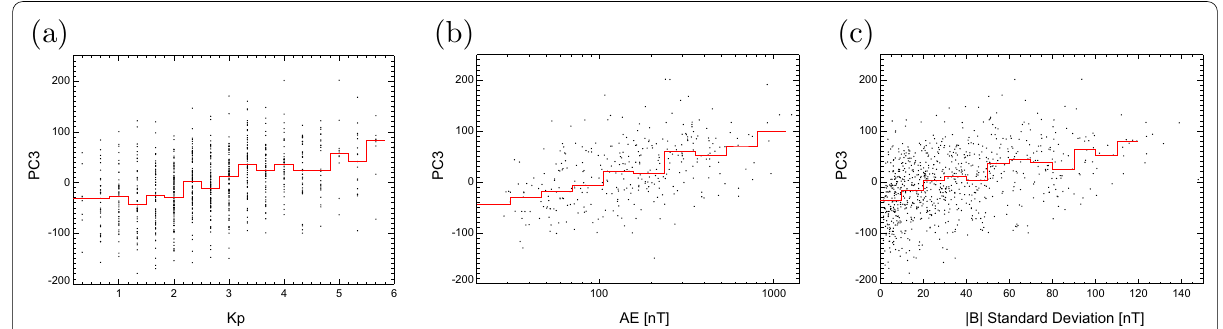
Fig. 5 Dependence of the PC3 coefficients on ( a ) Kp index, ( b ) AE index, and ( c ) standard deviation of the magnetic field magnitude measured by the Sodankylä magnetometer. Black points correspond to the values obtained for individual frequency–time spectrograms. Red lines show median values in given